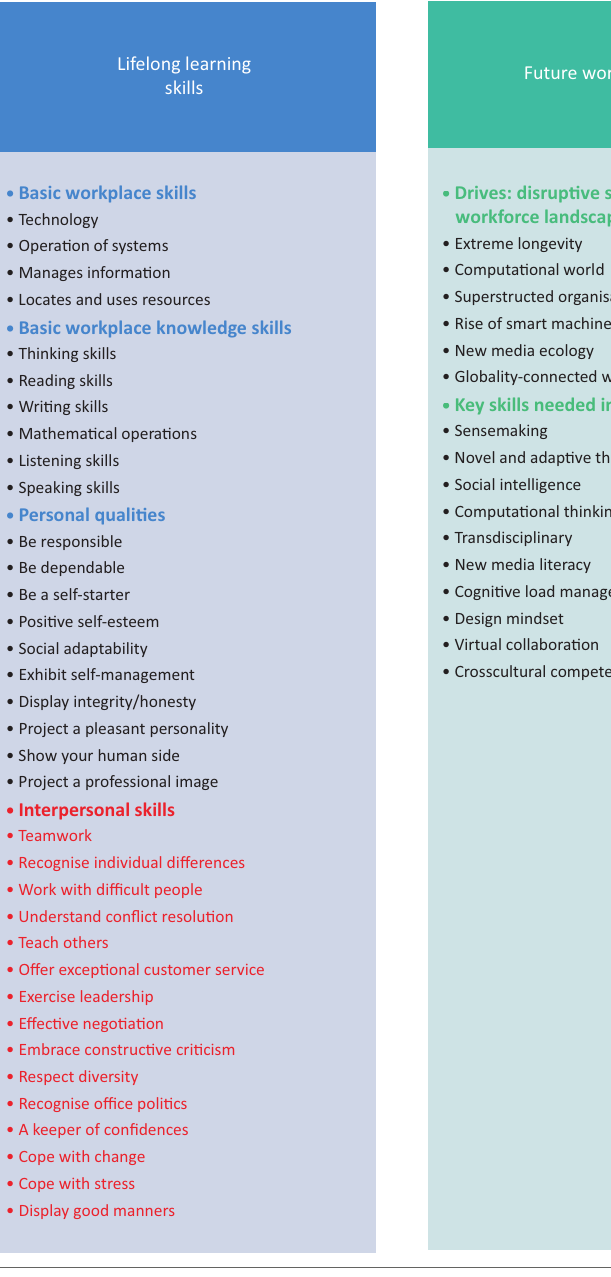
FIG URE 1: A guide for the key drivers of